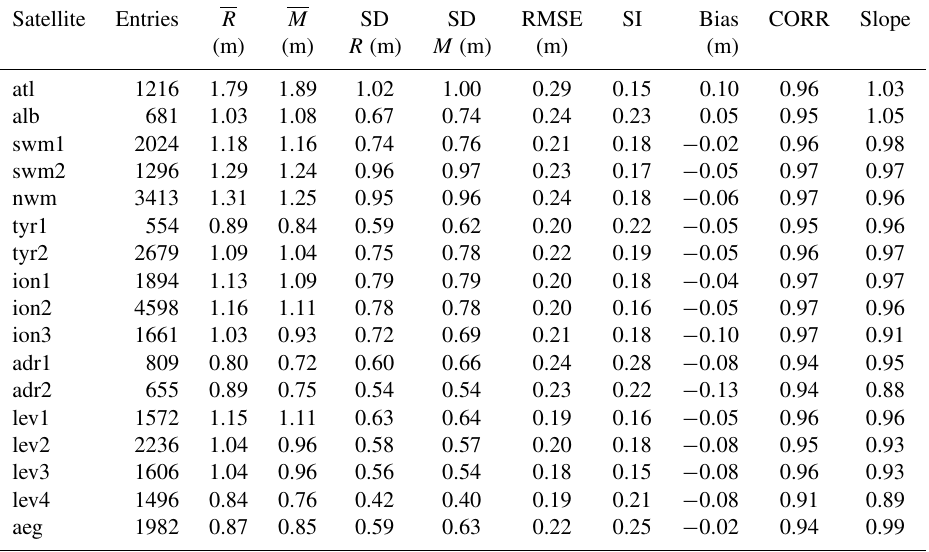
Table 5. Med-waves H s evaluation against satellite H s (Jason-2 and SARAL), for each individual Mediterranean Sea subregion shown in Fig. 3, for a 1-year period